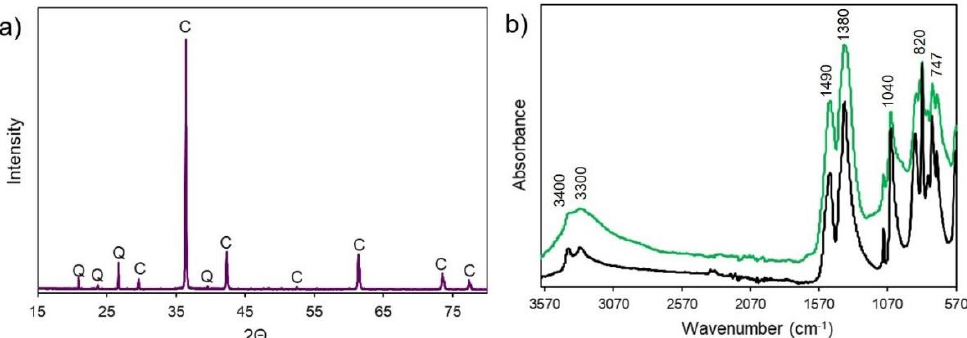
Figure 8. ( a ) XRD spectrum of dark brown patina on a copper alloy thimble from the Rooswijk after conservation, with diffraction peaks indicating the presence of cuprite (C) and quartz (Q); ( b ) ATR- FTIR spectrum collected from the green patina from the thimble after conservation (green spectrum) and the FTIR spectrum of a reference sample of malachite (black spectrum).